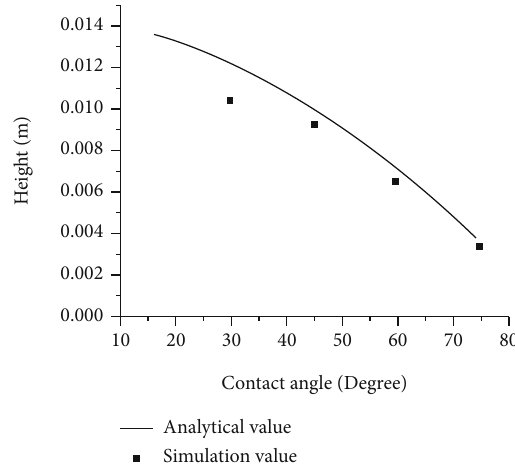
Figure 1: Veri fi cation of numerical simulation results.